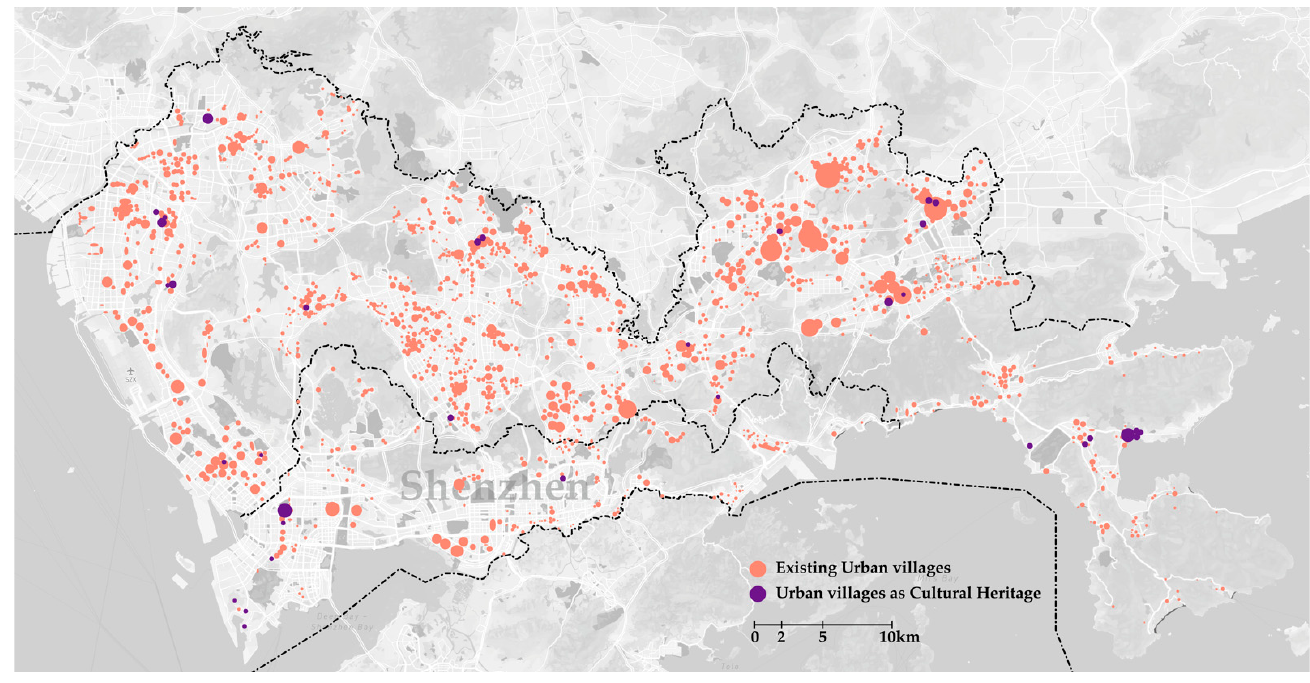
Figure 2. Existing urban villages in Shenzhen: data from Shenzhen Urban Planning Bureau.